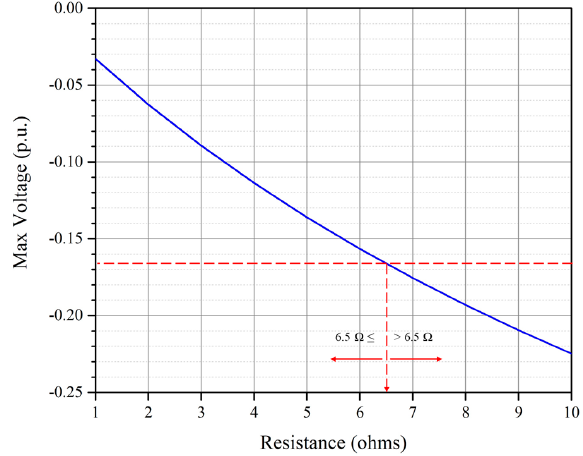
Figure 21. Maximum sheath-ground overvoltage at the entrance of the cable resulting from a lightning strike on the negative OHPC at the transition tower.